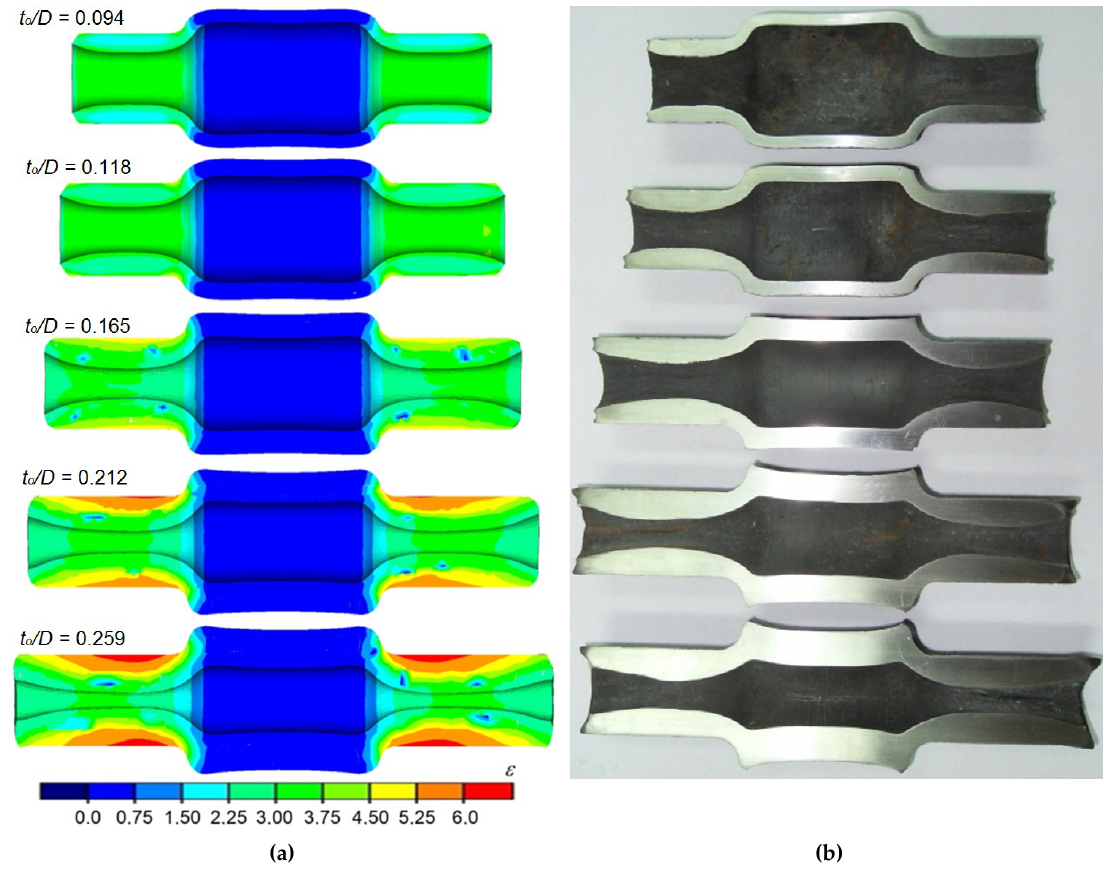
Figure 6. Shape of the formed shafts with extreme neckings: ( a ) finite element method Figure6. Shapeoftheformedshaftswithextremeneckings: ( a )finiteelementmethod(FEM)-determined (FEM)-determined (along with the effective strain distribution); ( b ) obtained during laboratory (along with the e ff ective strain distribution); ( b ) obtained during laboratory testing ( δ = 1.5; testing ( δ = 1.5; v/n = 4 mm/rotation) v / n = 4 mm /